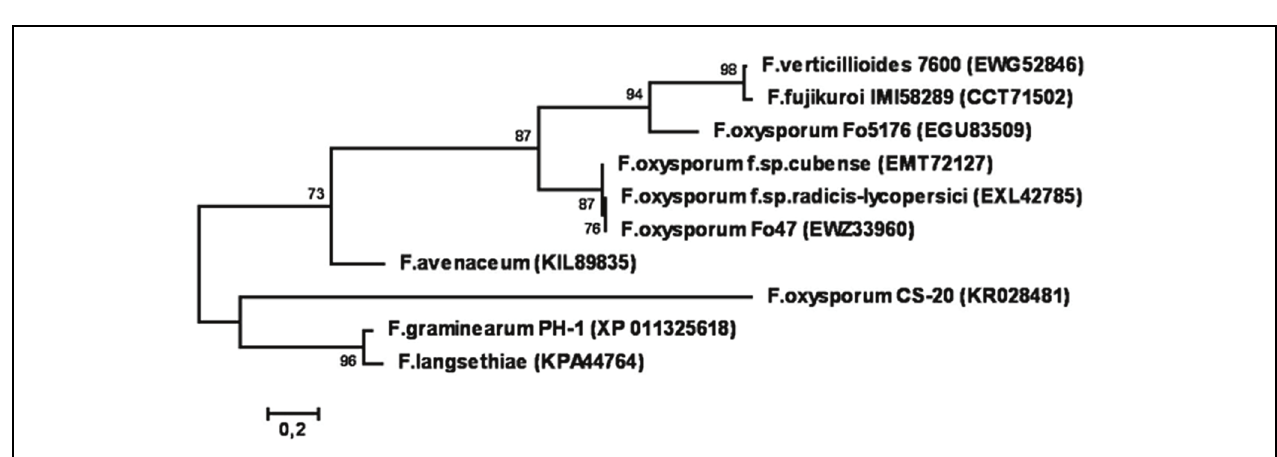
FIGURE 11 | Phylogenetic tree reconstructed for sequences of CS20EP and its homologs from different Fusarium species. Only bootstrap values greater than 70% are indicated.